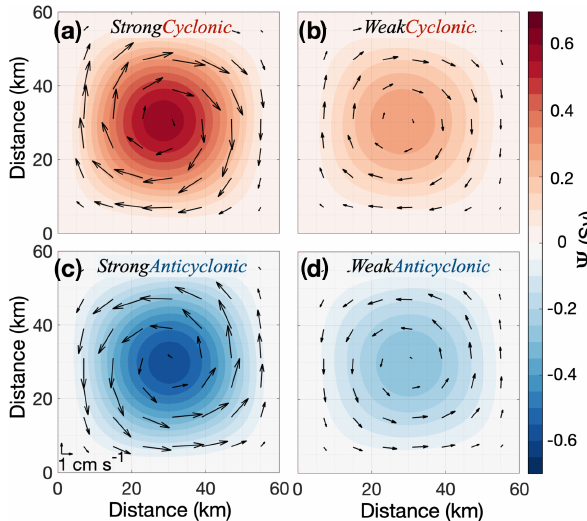
Figure 8. Simulated steady-state gyre streamfunction ( (cid:57) ) and cur- rent velocity, when sea ice is absent. Shading indicates streamfunc- tion while arrows indicate current velocity (only every eighth arrow is plotted for clarity). The wind forcing for each of panels (a) – (d) is shown in Fig.